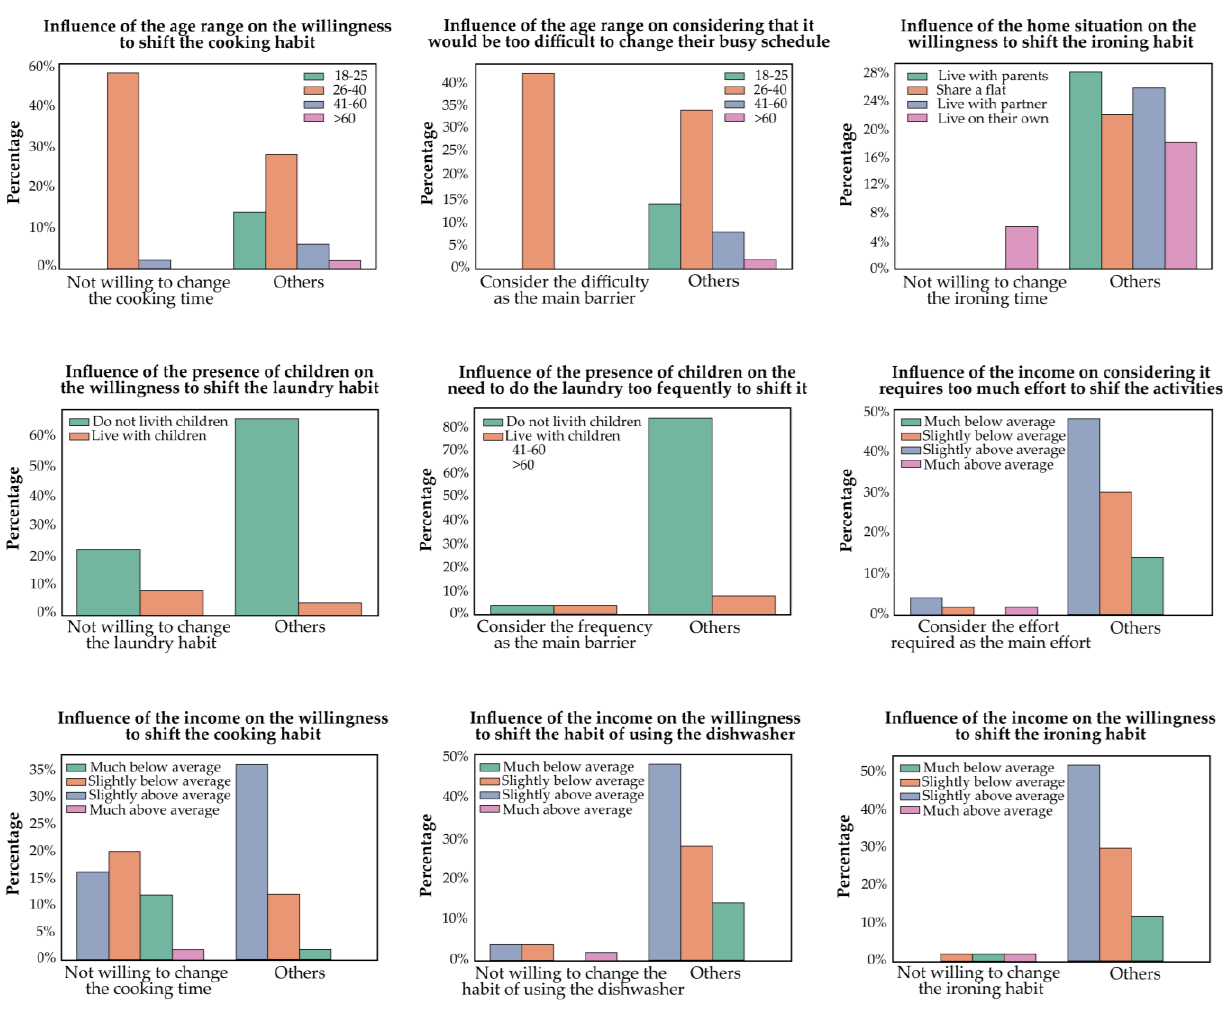
Figure 3. Countplots of the significant differences in demographics on willingness to change habits. The y -axis expresses the percentage of respondents, while the categories of the independent variables are shown in the legends. Since the items required a binary answer, the two poles are presented on the x -axis.